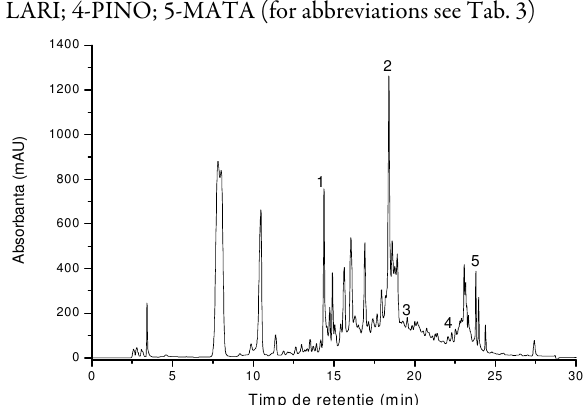
Fig. 4. Flax seeds sample chromatogram: 1-SDG; 2-SECO; 3-LARI; 4-PINO; 5-MATA (for abbreviations see Tab. 3)